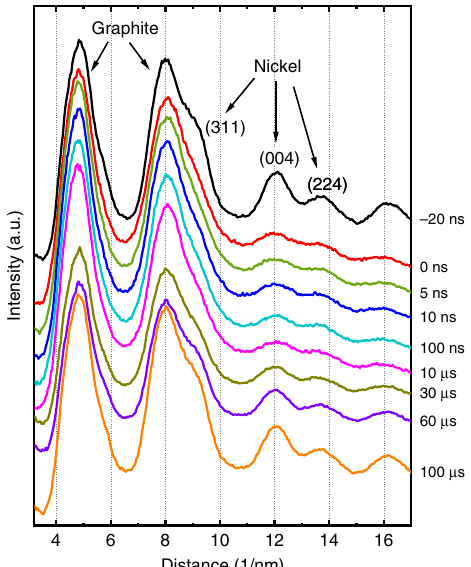
Fig. 2 Melting and resolidi fi cation of Ni. Diffraction pro fi les taken from Ni particles on a carbon grid. The vanishing of the diffraction peaks from Ni shows the immediate melting of the particles within a few ns after the laser pulse. Each curve is the sum of 100 single-shot diffraction patterns at the same delay. The uppermost curve was taken 20 ns before the heating. The two prominent diffraction peaks at low diffraction angles are the graphite rings from the slightly graphitized carbon grid